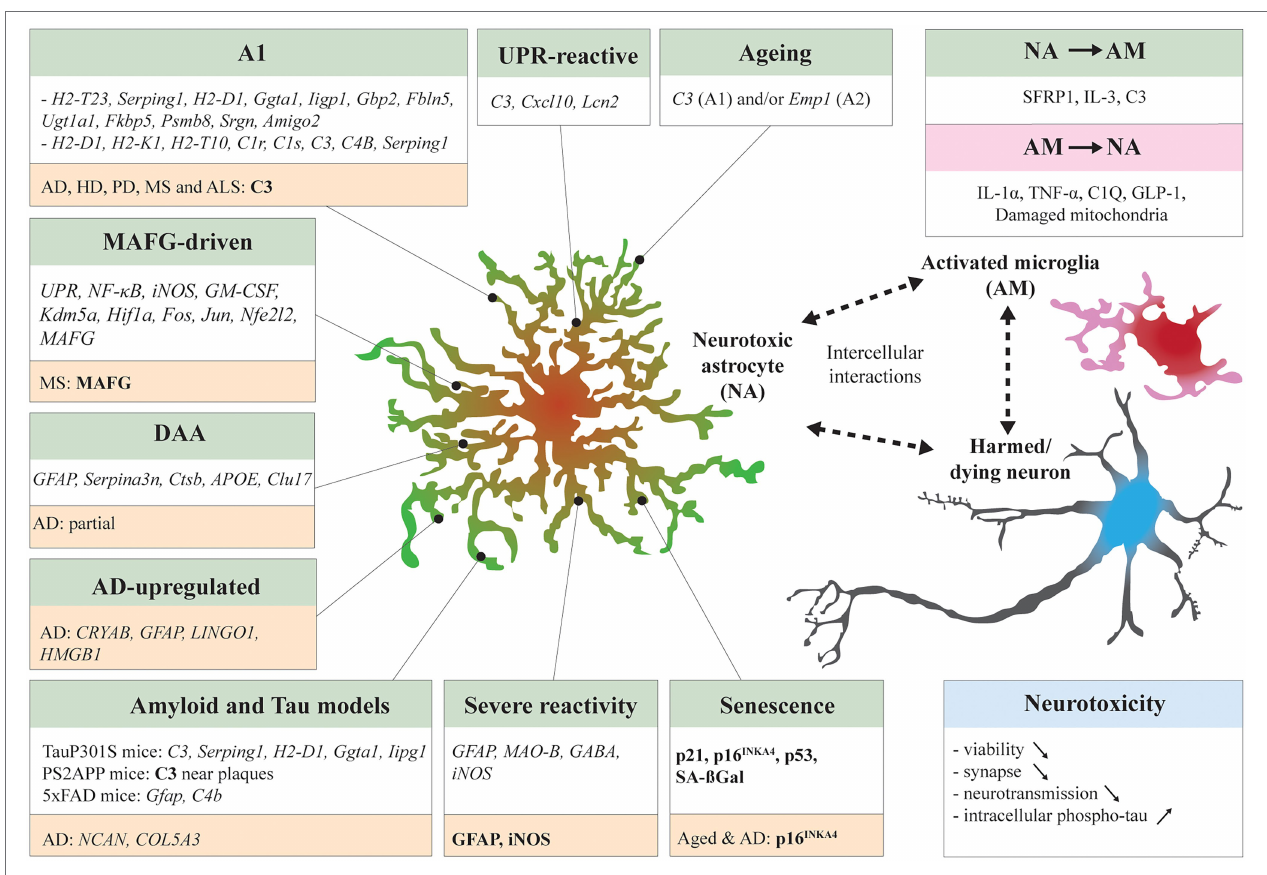
FIGURE 1 | Neurotoxic astrocytic signatures and interaction with neighboring cells. Many studies have identified neurotoxic astrocytic molecular signatures (italic) and markers (bold) across specific experimental conditions: A1 in systemic LPS treated mice (Zamanian et al., 2012; Liddelow et al., 2017), unfolded protein response (UPR)-reactive astrocytes in UPR-activated mice and prion-diseased mice (Smith et al., 2020), musculoaponeurotic fibrosarcoma homolog G (MAFG)- driven astrocytes in experimental autoimmune encephalomyelitis (EAE) mice (Wheeler et al., 2020), Disease associated astrocytes (DAAs) in 5xFAD mice (Habib et al., 2020), Alzheimer’s disease (AD)-upregulated astrocytes in AD patients (Lau et al., 2020), Aged mouse astrocytes (Clarke et al., 2018), senescent mouse astrocytes (Bussian et al., 2018; Gaikwad et al., 2021), and severe reactive mouse astrocytes (Chun et al., 2020). Other studies have compared neurotoxic astrocyte signatures in distinct disease mouse models such as TauP301S mice and PS2APP mice (Wu et al., 2019) and 5xFAD mice (Zhou et al., 2020b). Some signatures overlapped between models. In NDDs patient samples, neurotoxic astrocyte markers have been identified by transcriptomics or IHC (highlighted in orange). The neurotoxic astrocytes are in close bilateral communication with surrounding cells. Activated microglia can induce astrocytes to adapt a neurotoxic profile (Liddelow et al., 2017; Joshi et al., 2019; Park et al., 2021), vice versa neurotoxic astrocytes secrete microglia-activating factors (McAlpine et al., 2021; Rueda-Carrasco et al., 2021). Finally, the induced neurotoxicity can decrease neuron viability, exacerbate synaptic loss, neurotransmission impairment, and tau pathology. Reciprocally, harmed or dying neurons can stimulate activation of microglia and reactivity of astrocytes (not detailed